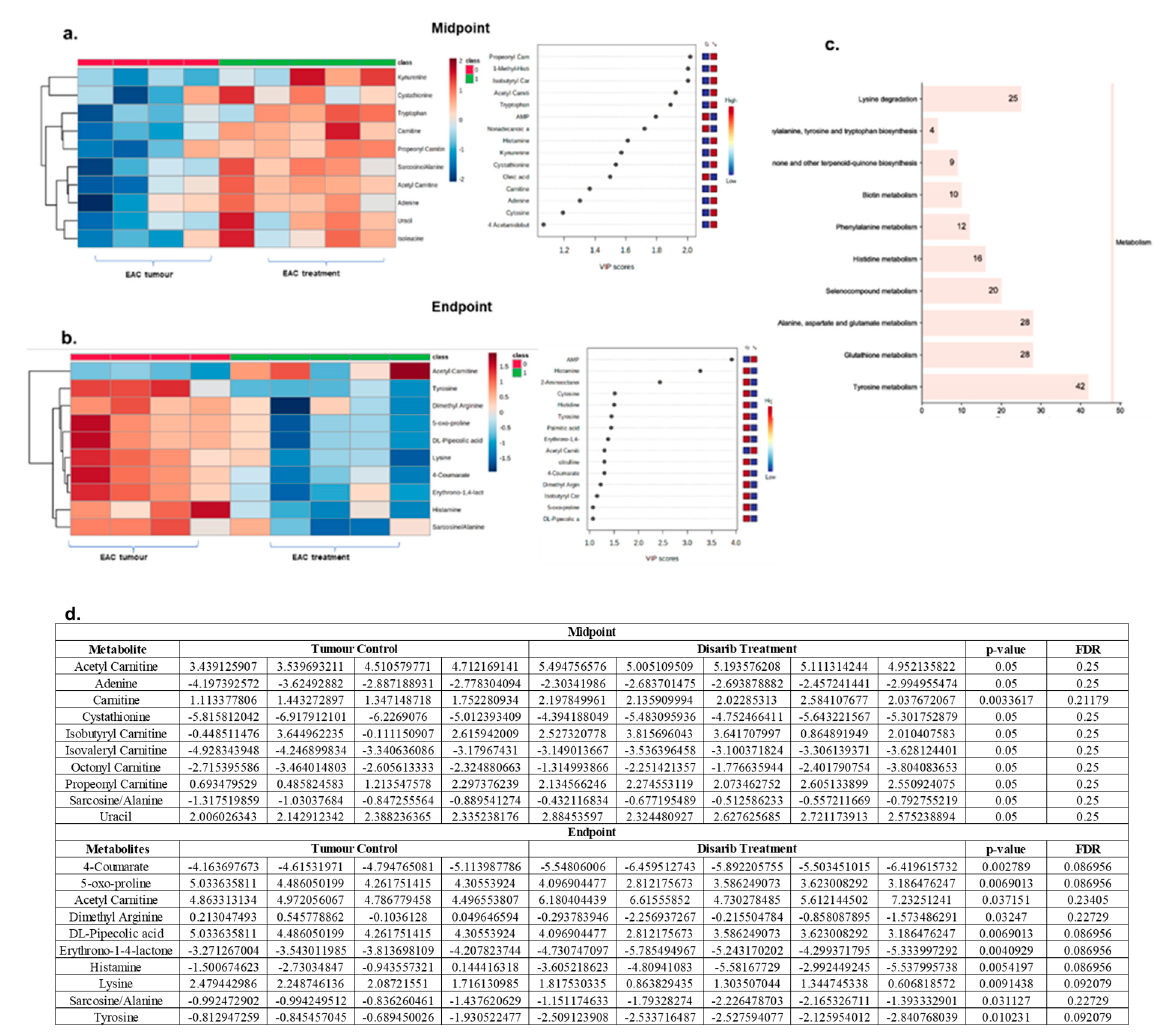
Figure 5. Metabolomics analysis of EAC tumour control and Disarib treated samples. Heatmaps depicting significant metabolites and VIP score plots were obtained from multivariate regression analysis. Top metabolites based on the VIP scores greater than are plotted for ( a ) Midpoint ( b ) End- point. Notations 0 and 1 represent tumour control and Disarib treated samples, respectively. The blue colour represents low expression, and the red colour represents high expression. ( c ) Pathway enrichment analysis of significant metabolites. The x -axis represents metabolite count, and the y -axis represents pathways. ( d ) Table showing normalized peak intensities, p -value and FDR for metabolites from midpoint and endpoint in tumour control and Disarib treated